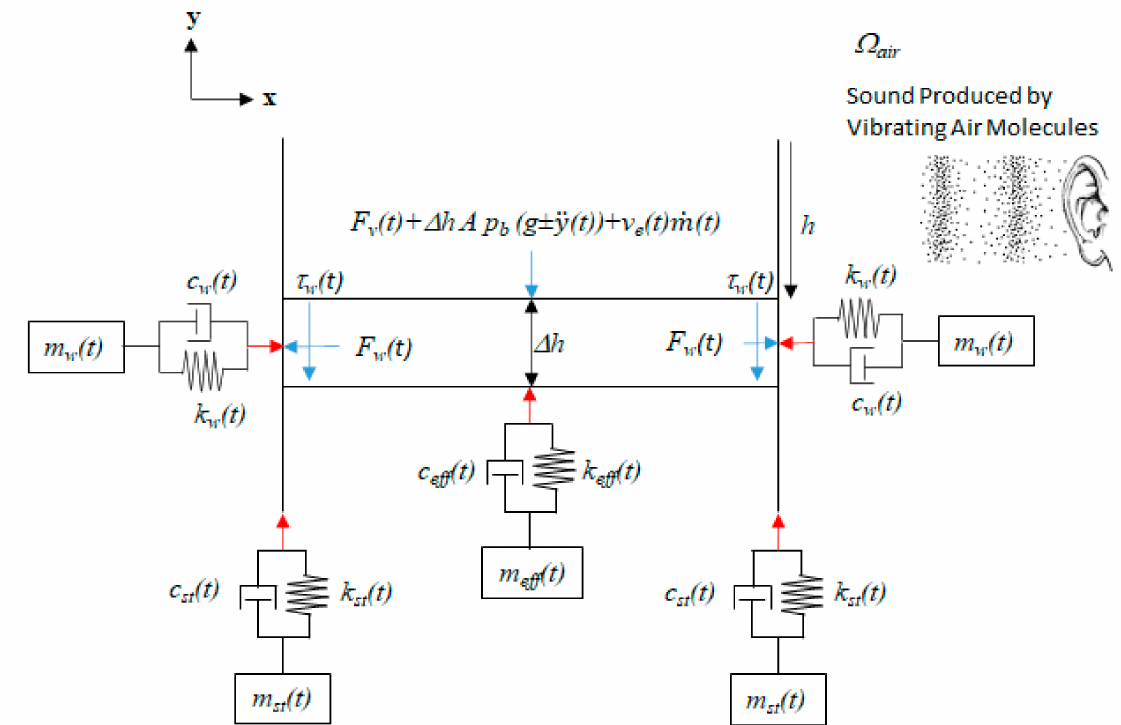
Figure 2. Graphical illustration of Equation (1) for a parallel wall